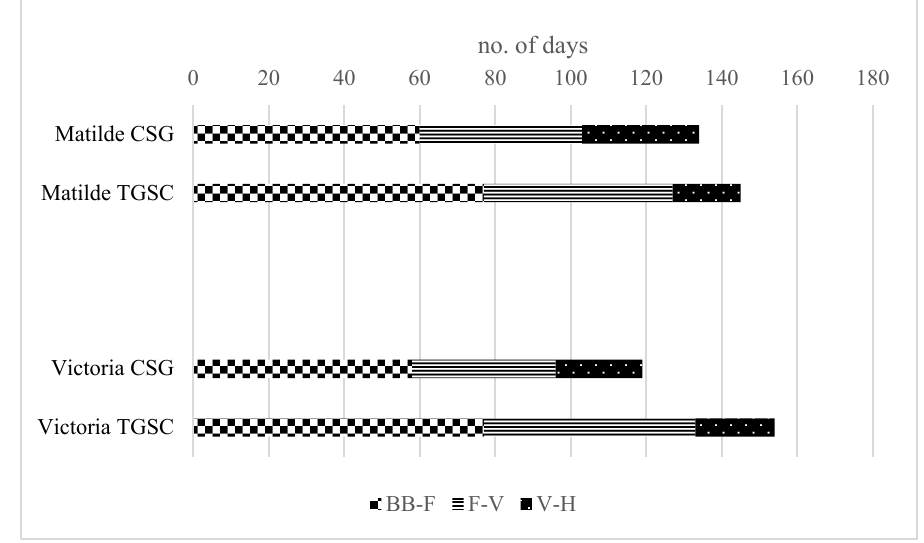
Figure 6. Length of intermediate phenological intervals and total duration (days) of ‘Matilde’ and ‘Victoria’ berry development in conventional soil-grown (CSG) cultivation and in soil-less (TGSC) cultivation. Phenological intervals: budbreak–flowering (BB–F); flowering–veraison (F–V) and veraison–harvest (V–H). Source: modified from [36]. Table 9. Climatic differences inside the greenhouse between the second and the first growing cycles’ phenophase occurrence in TGSC double-cropping system z